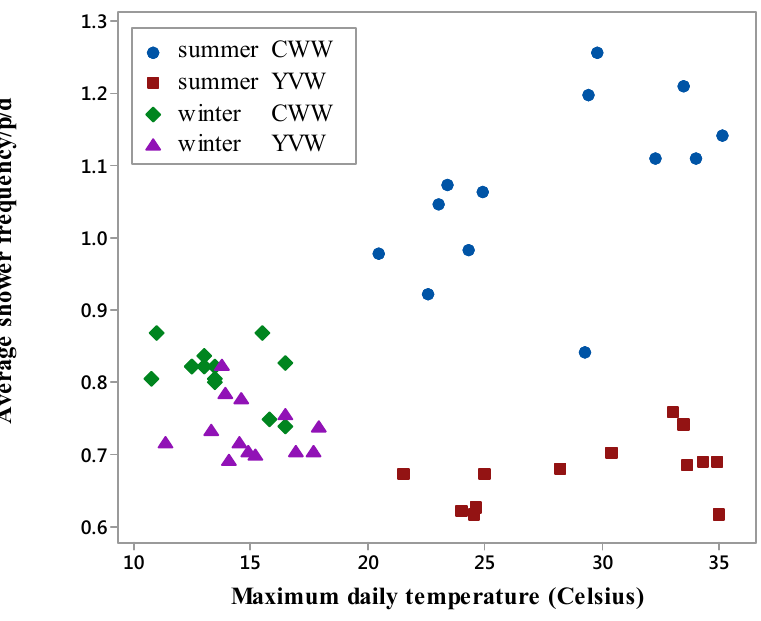
Figure 4. Scatter plot of average shower frequency/p/d and maximum daily